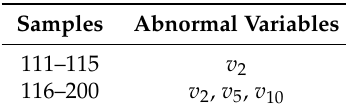
Table 4. Results of Abnormal Variable